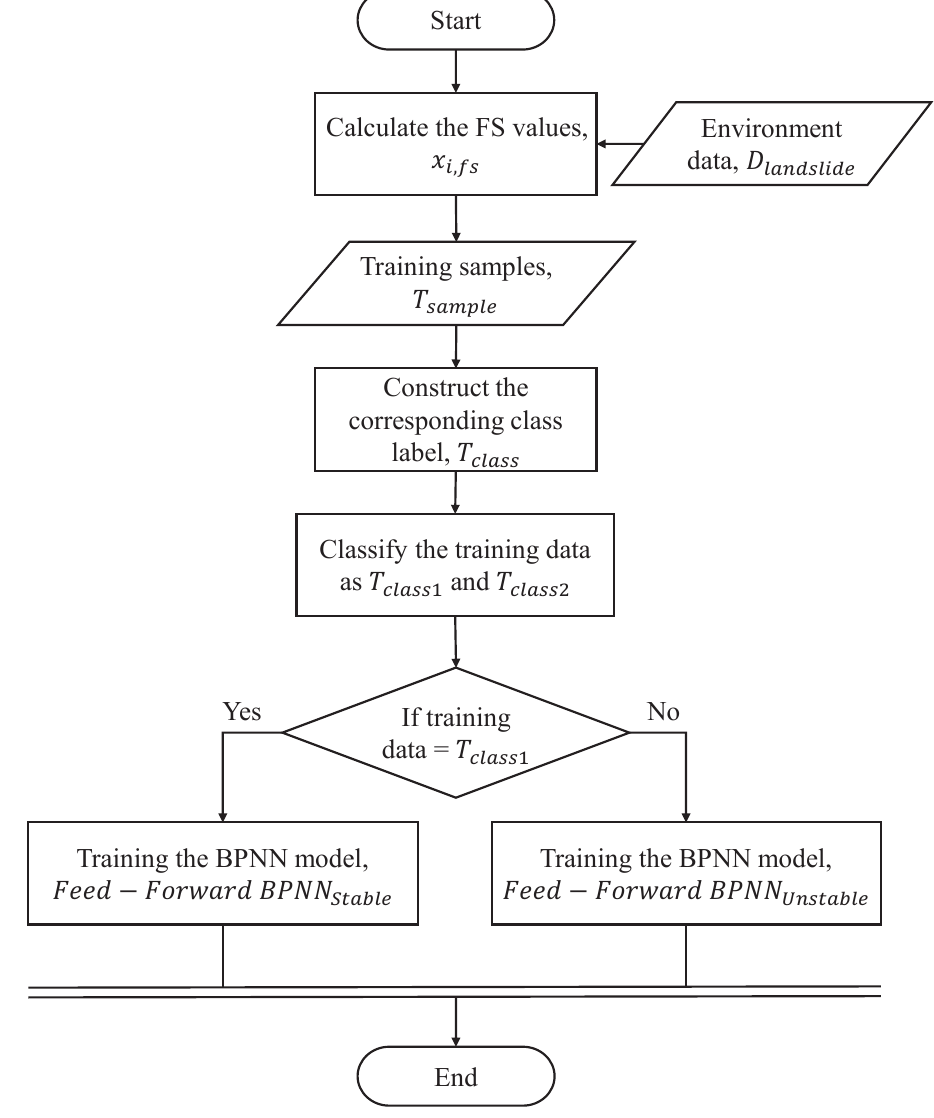
Figure 5. Flow of constructing different pattern